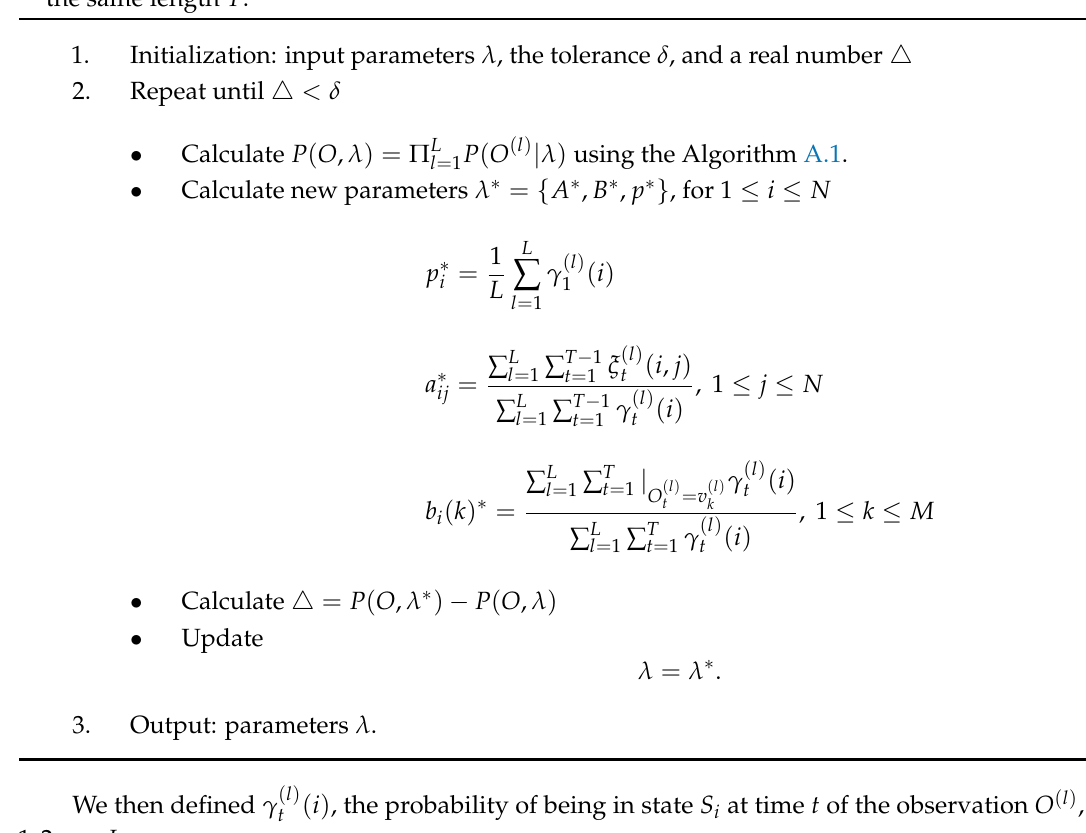
Algorithm A3: Baum–Welch for L independent observations O = ( O ( 1 ) , O ( 2 ) , . . . , O ( L ) ) with the same length T